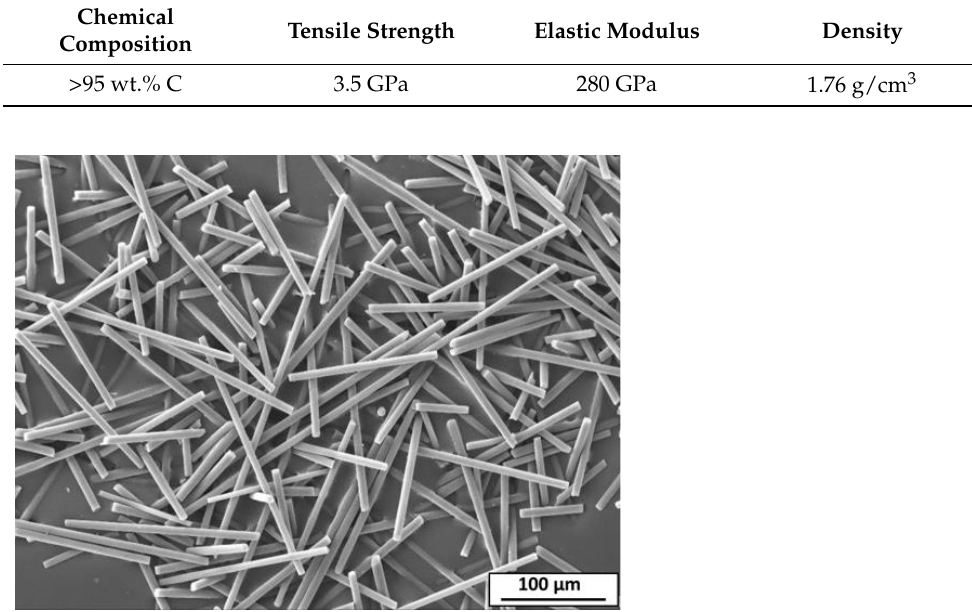
Figure 1. The SEM image of the short carbon fibers. Table 2. The chemical composition and mechanical properties of short carbon fibers.